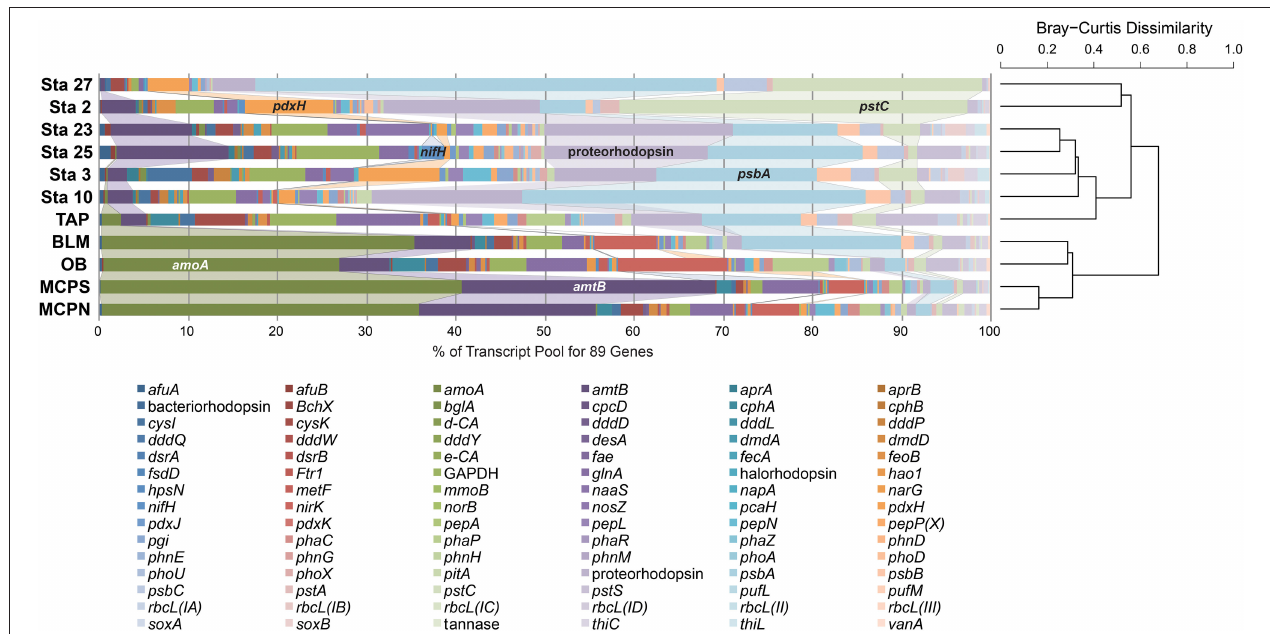
FIGURE 7 | Hierarchical clustering of relative abundance patterns of 89 biogeochemically-relevant genes in the metatranscriptomes from five Amazon River stations and six Amazon Plume stations. The samples were clustered using the Bray-Curtis Dissimilarity algorithm based on relative transcript